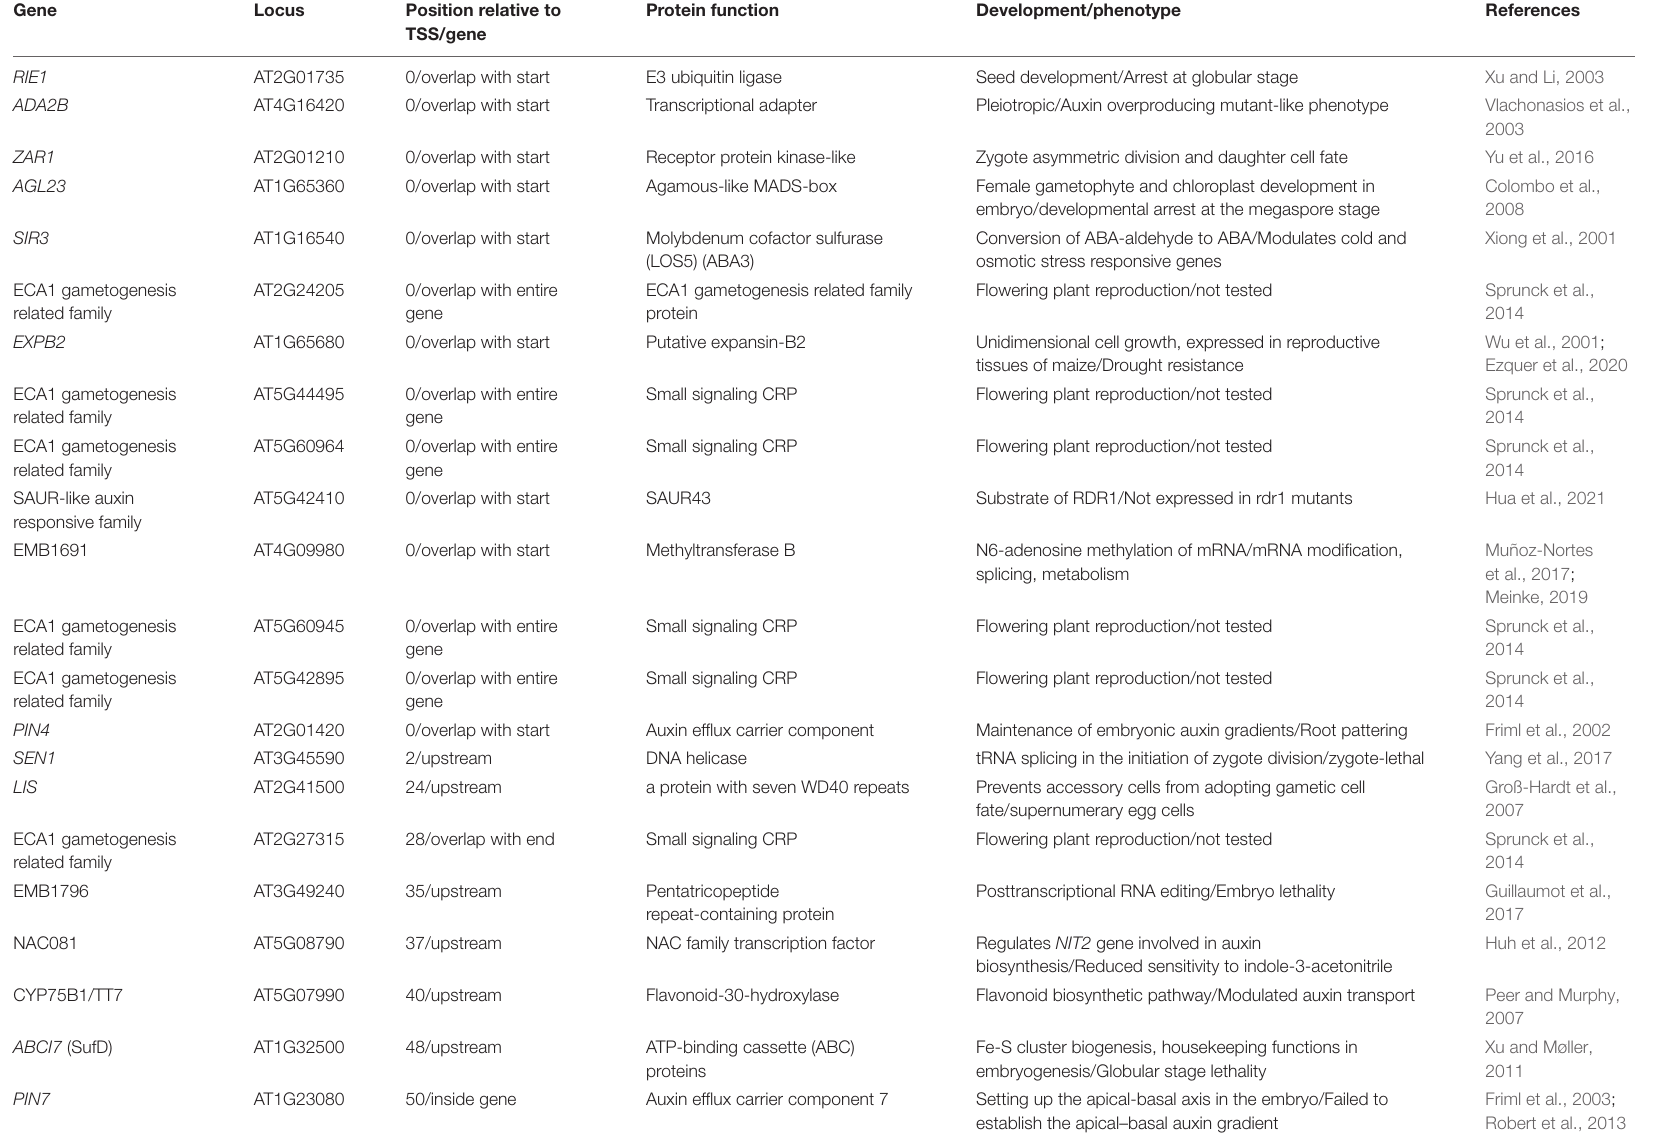
TABLE 2 | Potential PolV binding